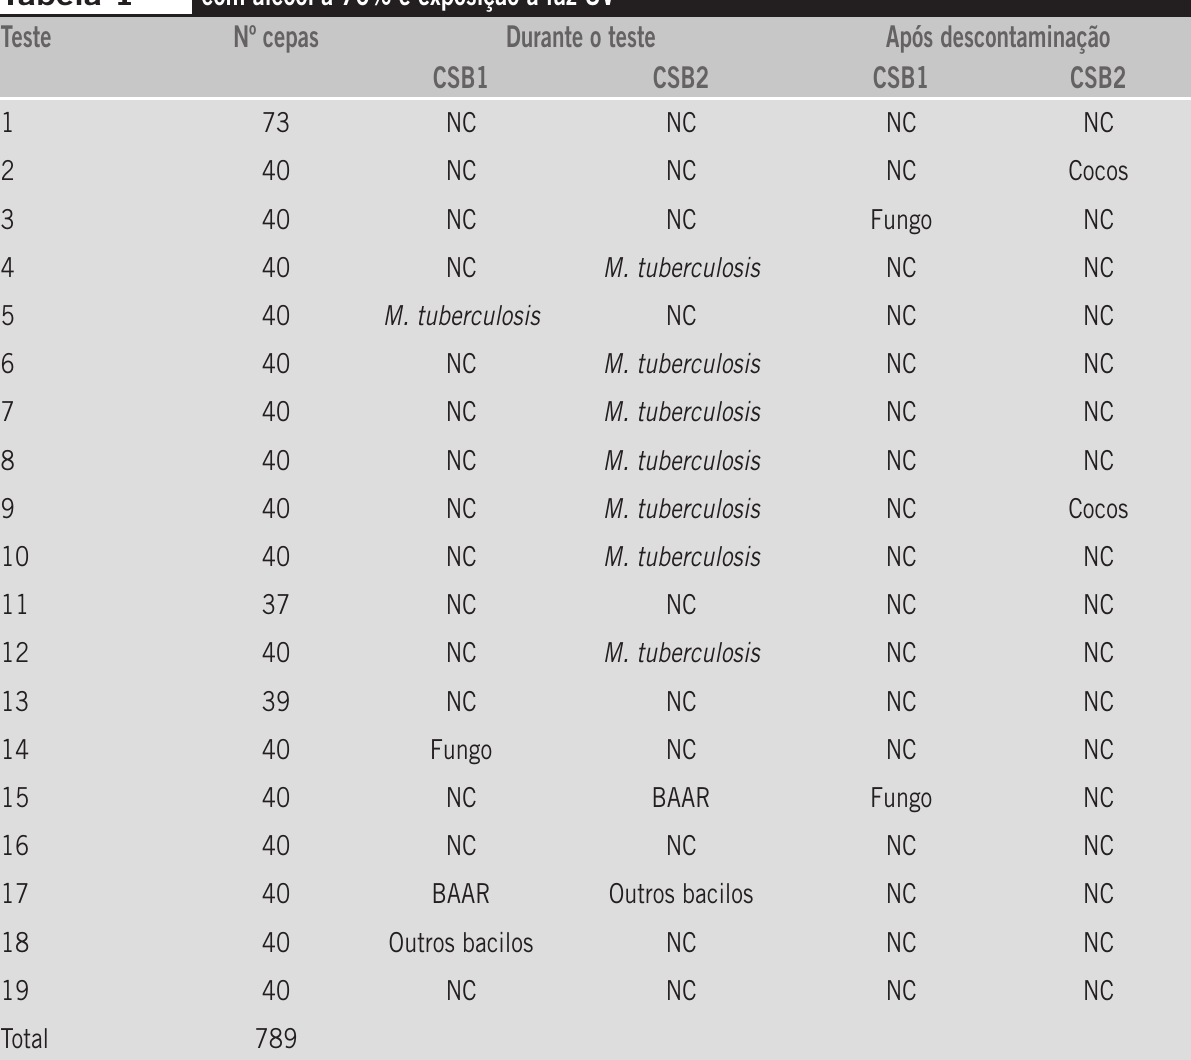
No caso de fungos houve crescimento espalhado; cocos e outro bacilo apresentaram uma a duas